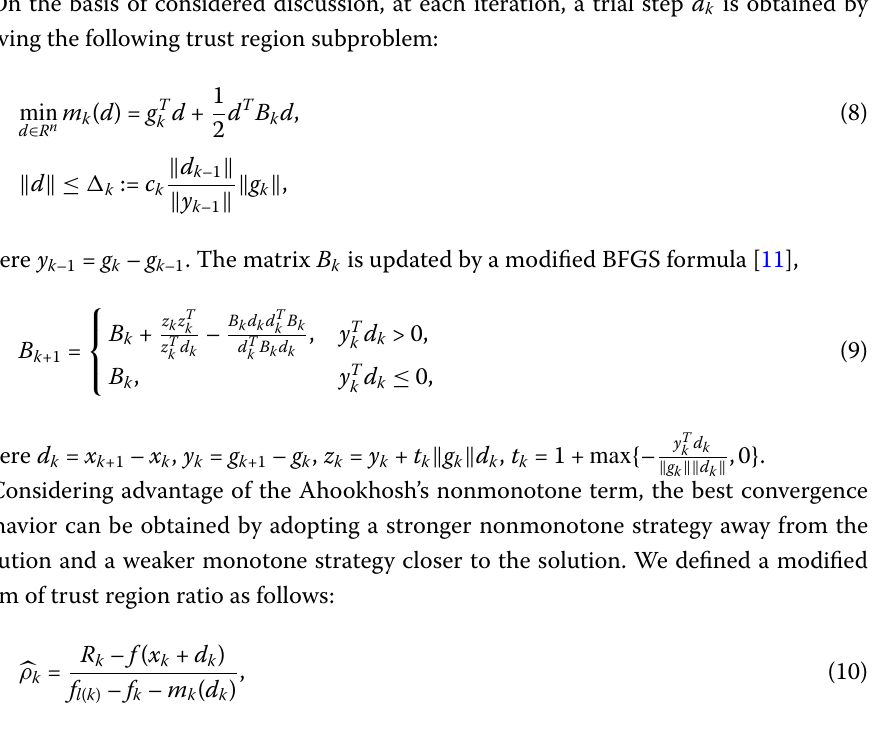
Algorithm 2.1 (New nonmonotone adaptive trust region